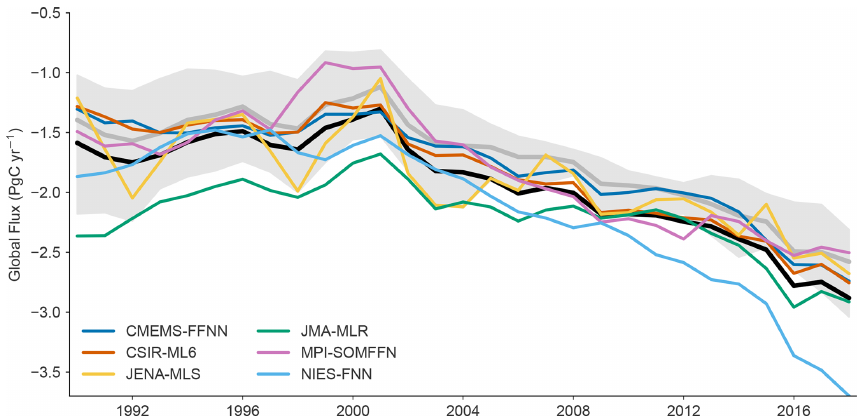
Figure 5. Global flux time series from six observation-based products. Color lines show fluxes calculated from the standardized approach presented here (spatial filling with flux is calculated from three wind products, and the average flux is then plotted here); the black line shows the mean of six products. The shaded region shows the spread of original flux calculations from product creators with the mean in